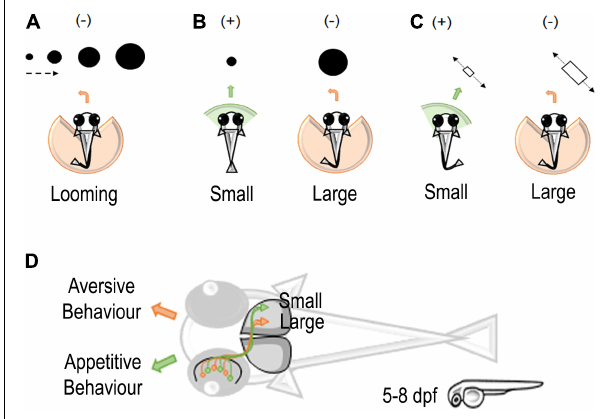
FIGURE 1 | Stimuli and neural circuits associated with prey capture in zebrafish larvae. (A) Looming-evoked escape (–) behavior in zebrafish larvae (Temizer et al., 2015). (B) A schematic representation of moving small or large dots entering the visual field of zebrafish larvae. Larvae tend to approach (+) small dots and avoid (–) large dots (Barker and Baier, 2015). (C) A schematic representation of moving small or large objects in zebrafish larvae. Small objects elicit an approach (+) interaction and large objects an avoidance (–) interaction (Preuss et al., 2014). (D) Classification of small and large objects in retinotectal circuits of zebrafish larvae eliciting an appetitive or aversive behavior in zebrafish larvae. Retinal ganglion cells (RGCs) detecting small objects project to the external layers of the zebrafish optic tectum. On the contrary, RGCs for large objects project to the deeper layer of the optic tectum (Preuss et al.,